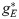
Model estimated best fit (a) excitation gE* and (b) inhibition gI* for the seven different mouse type datasets YACWT, YACHD, R62WT, R62HD, and Q175WT, Q175Het and Q175Hom (see key on (a)).Bars show weighted standard errors in estimated quantities (see Methods).